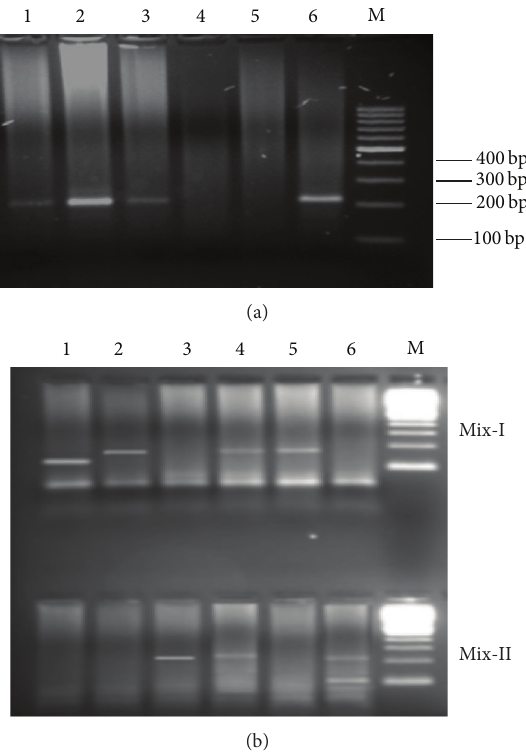
Figure 2: Percentage of HCV